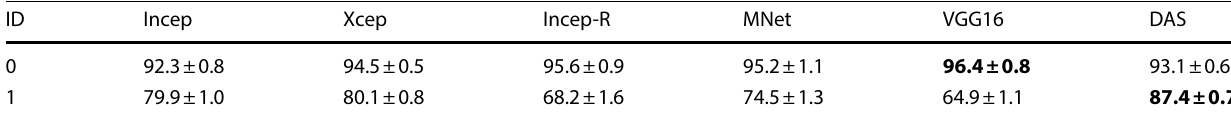
Fig. 11 Inference results using the Xception, VGG16 and DAS models with an image from the Oil Spill dataset. From left to right, the original SAR image (VV